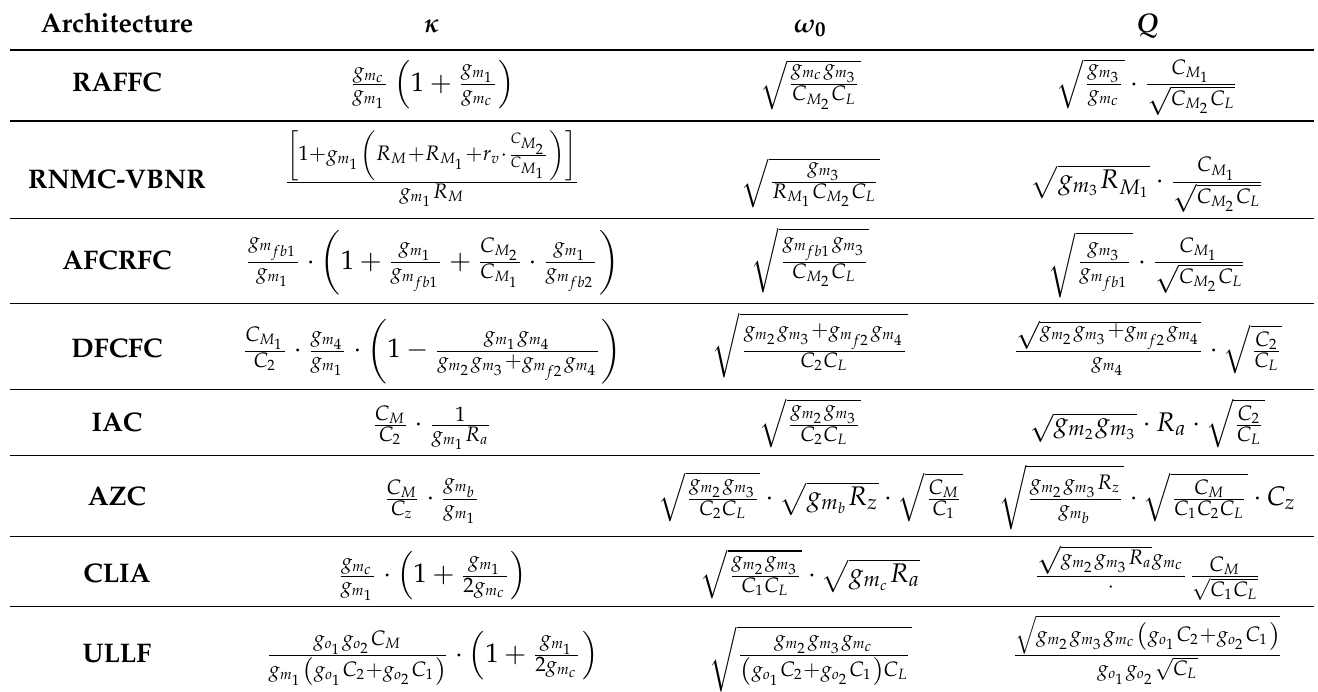
Table 7. Analytical expressions for the proposed FoM and non-dominant pole parameters for the compensation architectures of Figure 11.